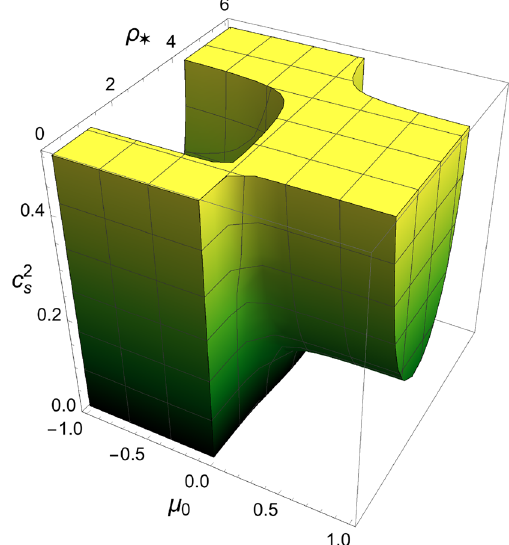
Fig. 3 Regions of existence H cp > 0 (Eq. (38)) within (μ 0 ,ρ ∗ , c 2 s ) parameter volume, for closed Snyder NC quantum cosmology with equation-of-state indexes close to − 1 (here ω = − 0 . 95) and any arbi- trary values n ∈ ( 0 , 1 ] , (cid:3) ∗ m ∈ ( 0 . 2 , 0 . 5 ) and C , D >